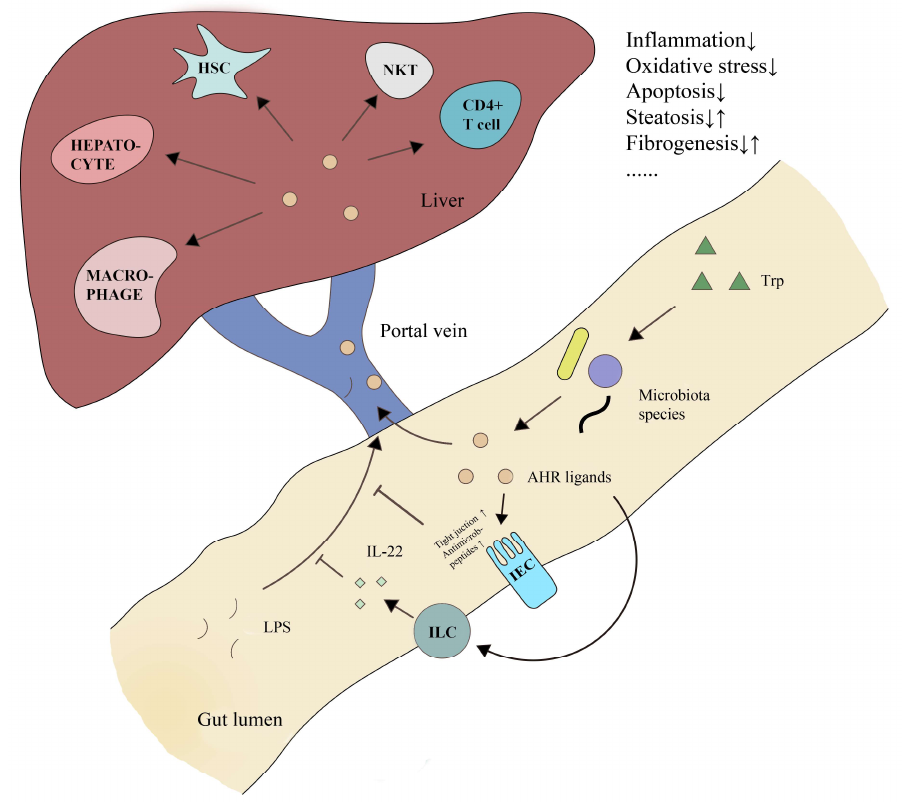
Figure 3. Gut microbiota-regulation of AHR signaling in liver physiology and pathology. Specific microbiota species (e.g., Lactobacillus spp.) can use and degrade dietary Trp, producing endogenous AHR ligands (mainly indole derivatives). On the one hand, AHR signaling can improve tight junction and antimicrobial peptide expression in IECs and the IL-22 production in ILCs, thus enhancing epithelial integrity and intestinal homeostasis. Under pathological conditions, AHR ligands are beneficial for improving gut permeability and blocking endotoxin translocation. On the other hand, previous studies have revealed that AHR signaling plays an important role in multiple cell types, especially immune cells. Gut-derived AHR ligands can regulate target cells in the liver through portal vein transmission. Generally, AHR signaling is characterized as an anti-inflammatory factor that protects against pathogenic inflammation and oxidative stress, exhibiting therapeutic value in multiple liver diseases. However, under different conditions, AHR signaling can induce fibrogenesis and steatosis. Thus, the regulation of AHR signaling by altering the gut microbiota could be a microbial ecological therapeutic method for liver diseases. Abbreviations: Trp, tryptophan; AHR, aryl hydrocarbon receptor; IEC, intestinal epithelial cell; LPS, Lipopolysaccharide; ILC, innate lymphoid cell; HSC, hepatic stellate cell; IL-22, interleukin-22; NKT, natural killer T cell.